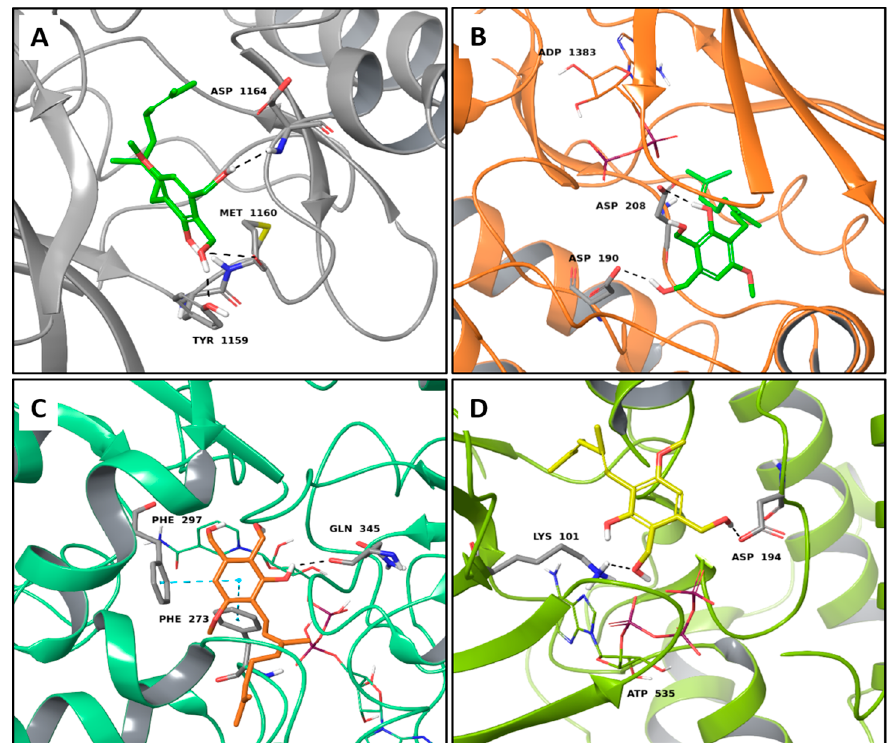
Figure 1. Molecular interactions of hericenol A and anticancer targets: ( A ) c-Met protein (PDB: 2WGJ). Protein is shown as a gray cartoon while ligand is shown as green carbon sticks; ( B ) MEK1 protein (PDB: 4ARK). Protein is shown as an orange cartoon while ligand is shown as green carbon sticks; ( C ) SIRT1 target (PDB: 4I5I). Protein is shown an aquamarine cartoon while ligand is shown as orange carbon sticks; ( D ) MEK2 protein (PDB: 1S9I). Protein is shown as a light green cartoon while ligand is shown as yellow carbon sticks. H-bonds and π - π interactions are shown as dashed black and cyan lines, respectively. Amino acid residues involved in the molecular interactions are shown as gray sticks.